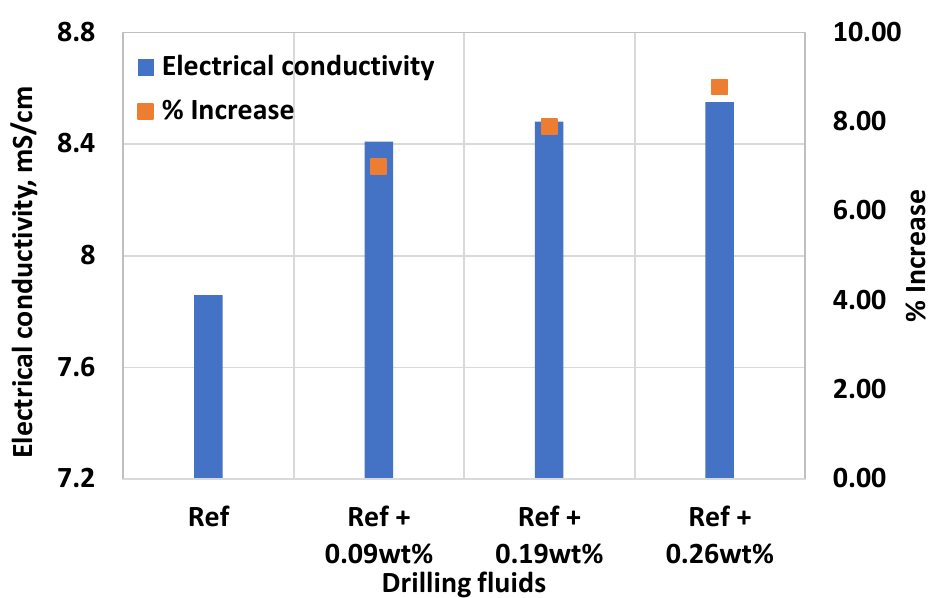
Figure 12. Effect of MoS 2 nanoparticle on the electrical conductivity of the base fluid.